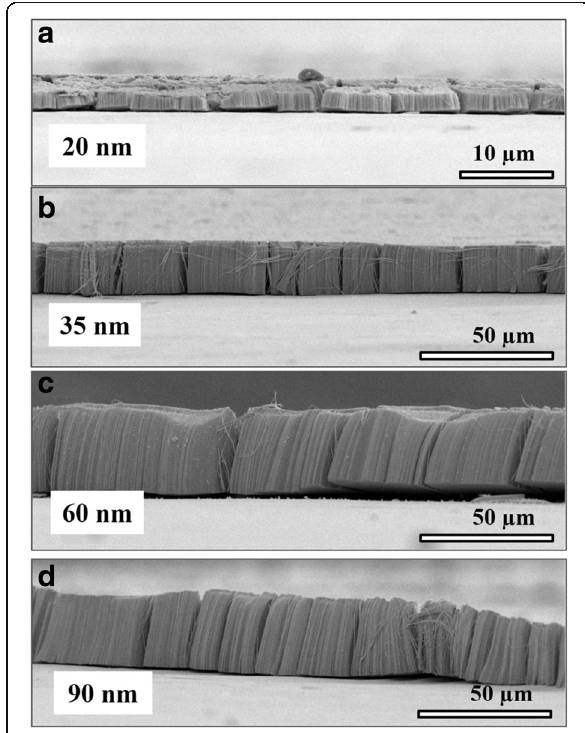
Fig. 2 SEM images showing the cross-sections of TaO x nanotubes with diameters of a 20, b 35, c 65, and d 90 nm,